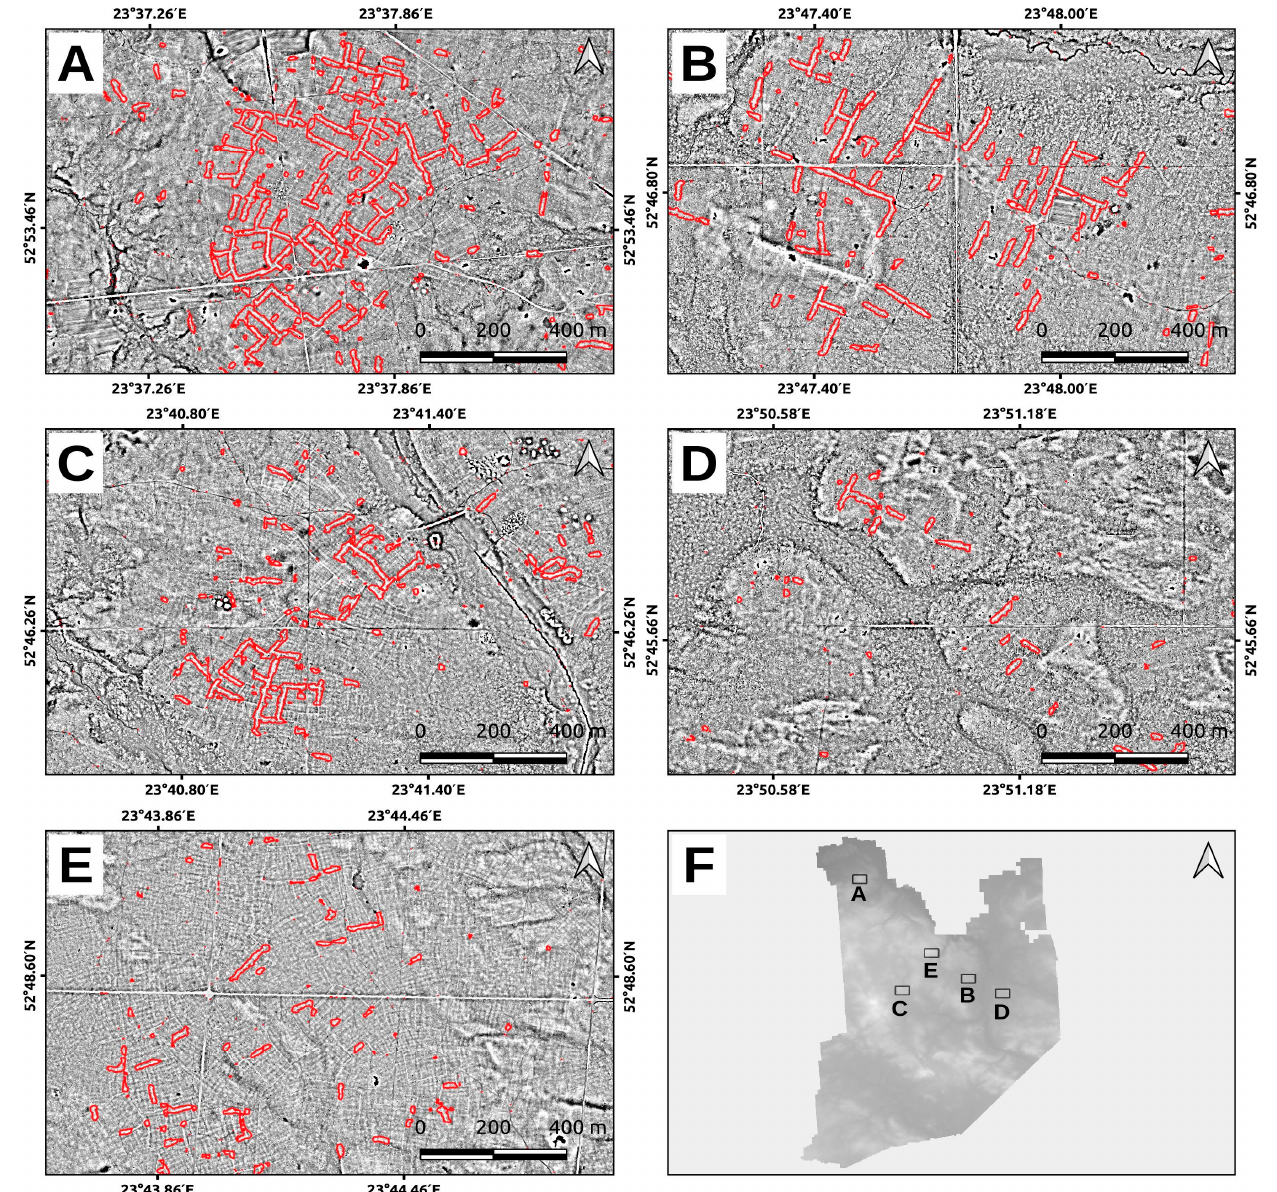
Figure 16. Example of ancient field system prediction mask contour (in red) from 5 areas of the Bi ‐ alowie ż a Forest ( A – E ). ( F ) is a map of the research area with the location of the examples.